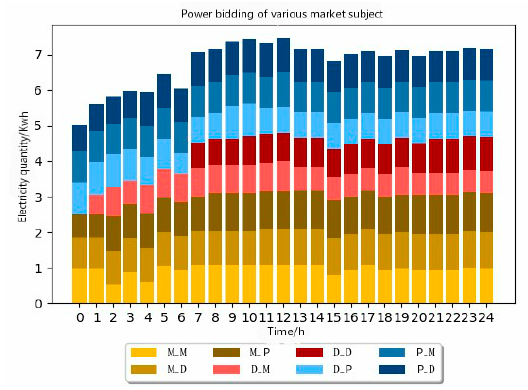
Figure 11. Power bidding of various market subject in 24-hours. Table 3. Near global optimum bidding strategy at 12:00 p.m.